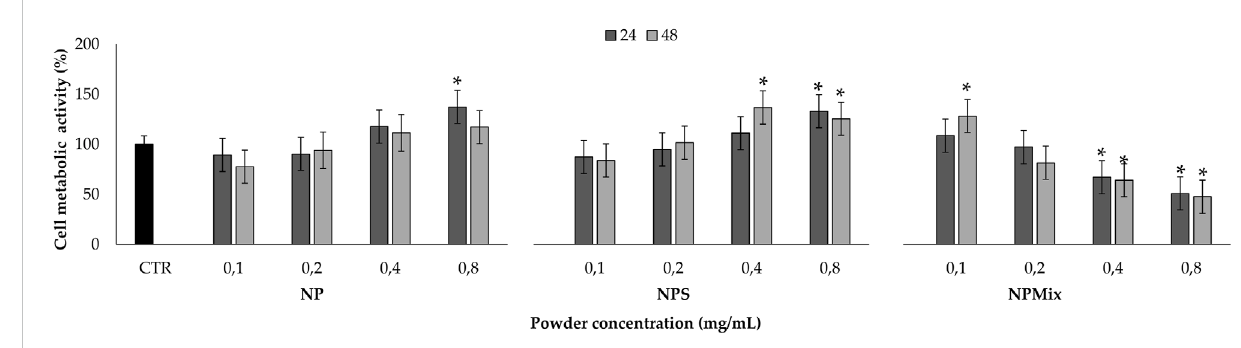
FIGURE 8 Samplecytocompatibility.Cellsnottreatedwithsamplesat24 hwereconsideredascontrols(100%ofthemetabolicactivity%).Dataarereportedas mean value ± LSD, Multifactor ANOVA, n = 3. *Indicates a signi fi cant difference with respect to the control ( p < 0.05).